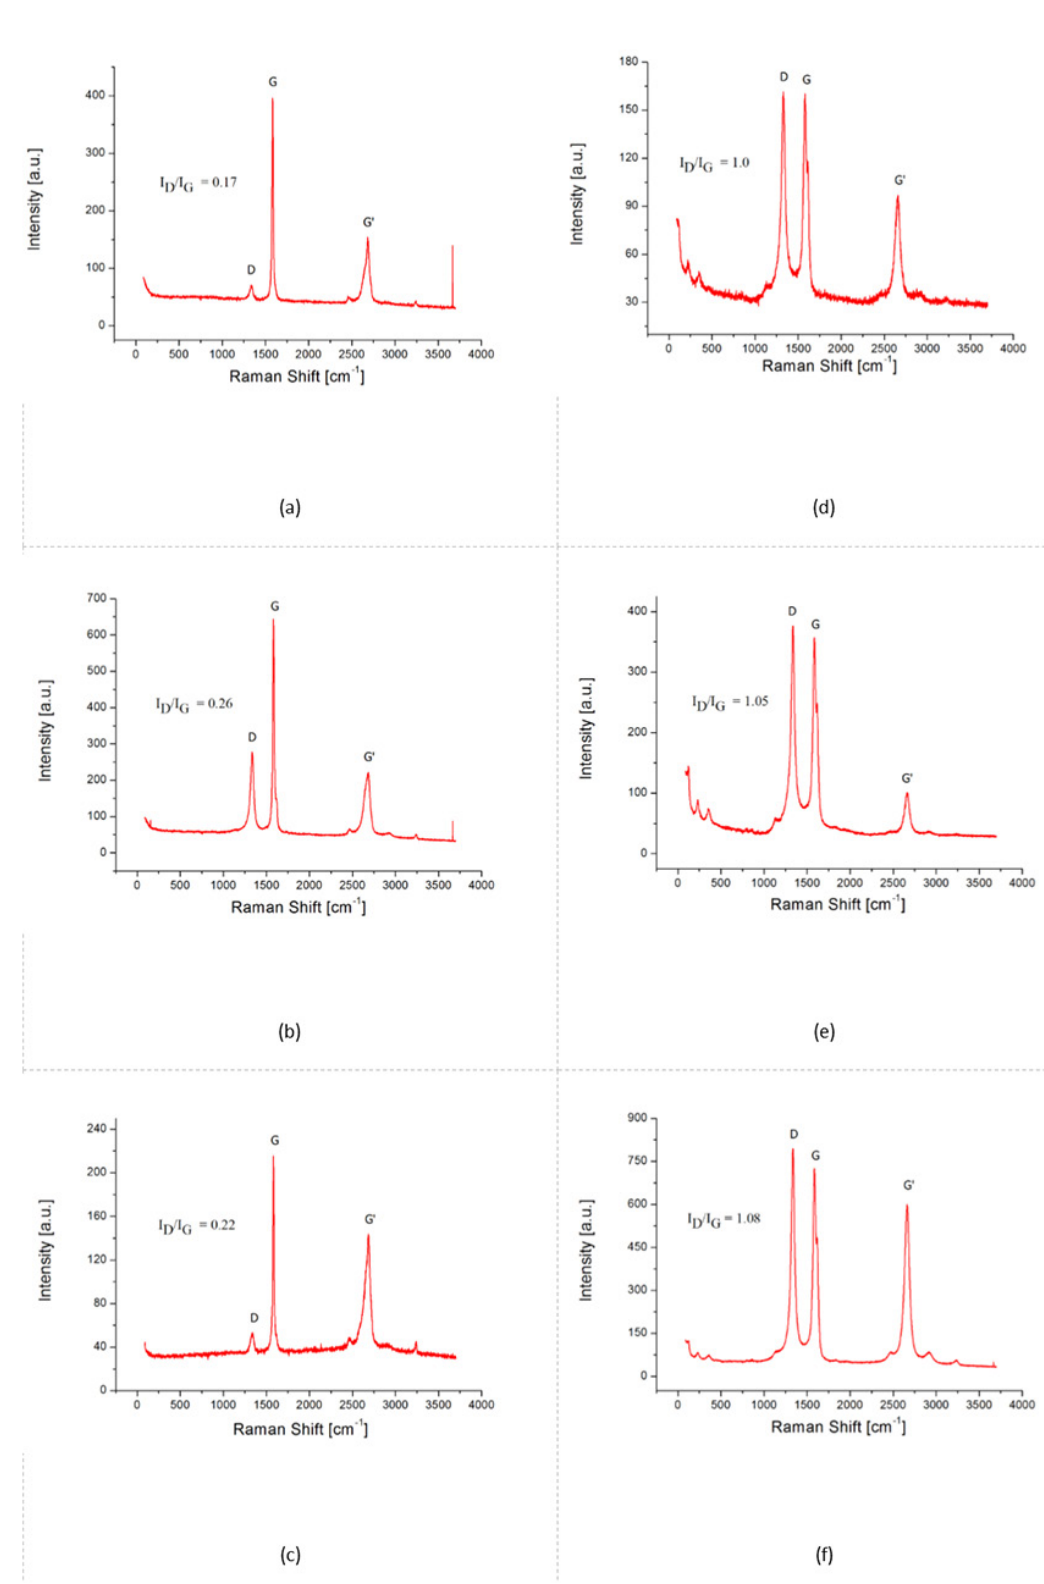
Figure 3. Raman Spectra. (a) MLG; (b) CO890+MLG; (c) SDBS+MLG; (d) CNT; (e) CO890+CNT; (f)